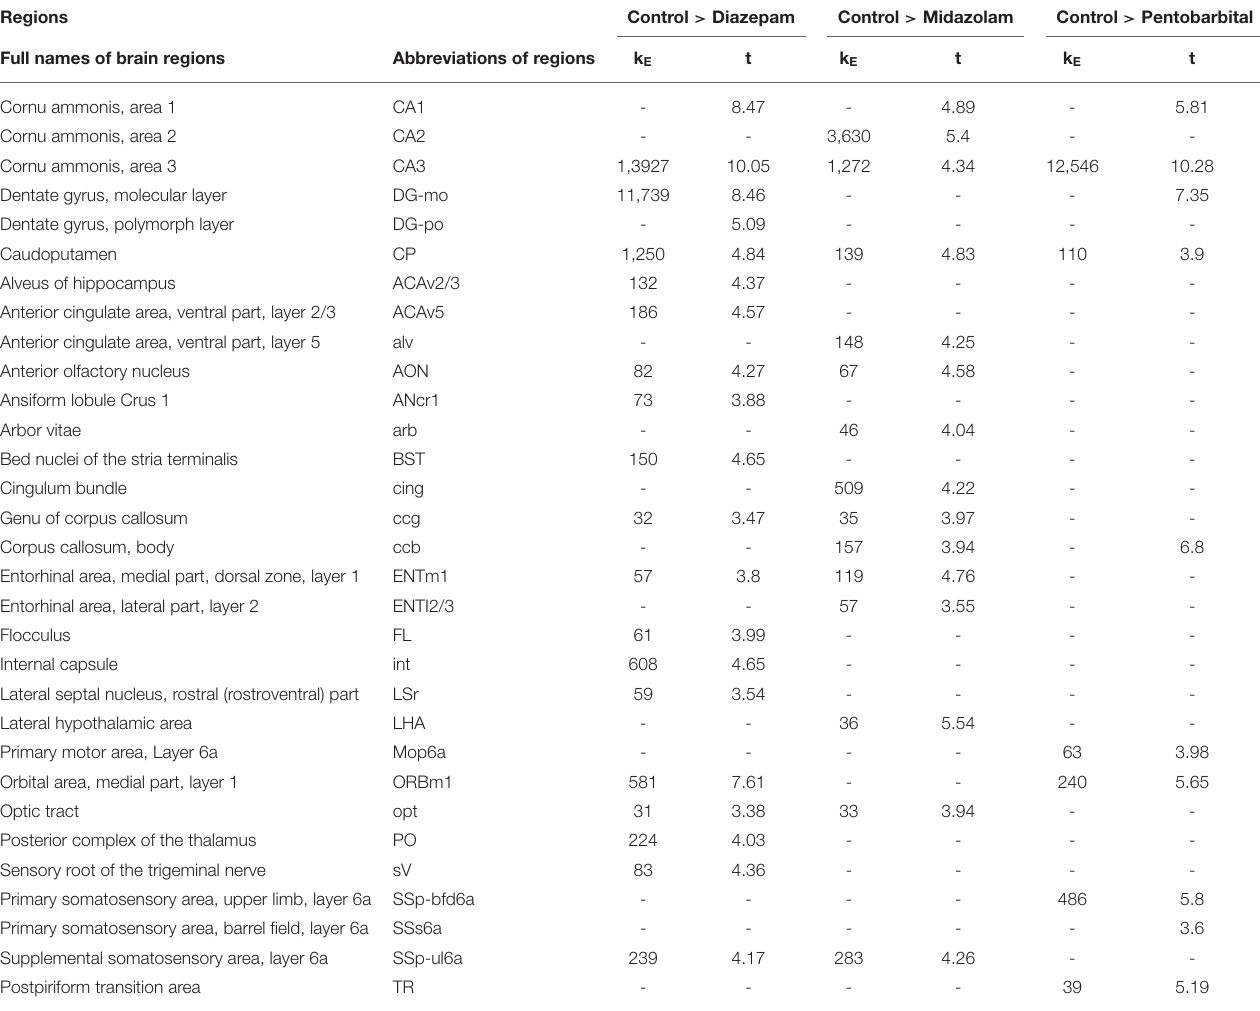
TABLE 1 | Summary of Voxel-based morphometry (VBM)